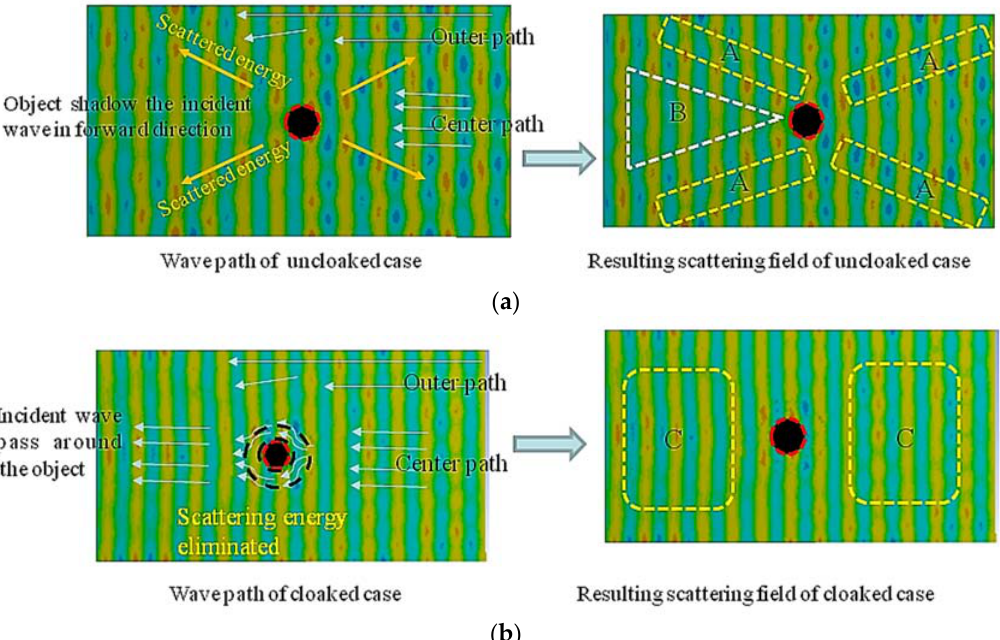
Figure 15. The resulting scattering fields of cloaked and uncloaked cases of incident wave at 1000 Hz. In ( a ) the uncloaked case, the incident wave interacts directly with the object and causes scattering in most directions (Region A) and strong scattering disturbances in the forward direction (Shadow Region B). In ( b ) the cloaked case, the anisotropic cloak shell guided waves at the center to pass around the cloak shell and restored the waves behind the cloak shell, reducing the disturbance led to the resulting scattering field of both forward and backward directions (Region C) with a far flatter wave front as in a free field.